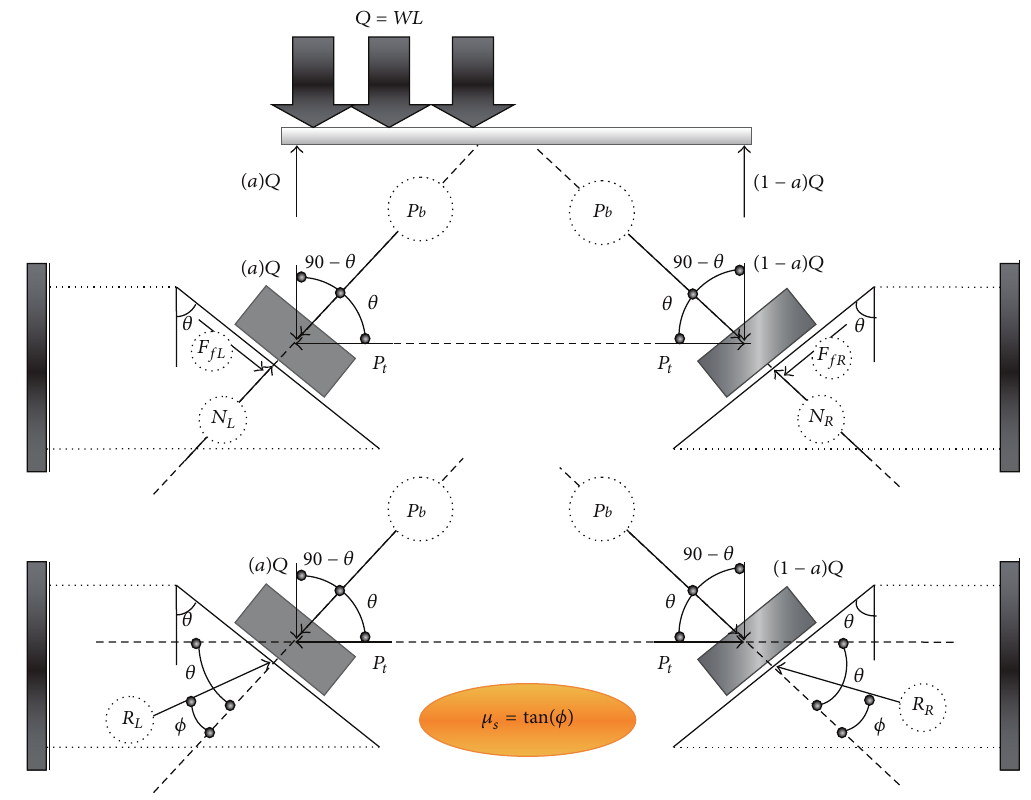
Figure 12: Free body diagram of beam with nonsymmetric gravity load after increase in temperature (friction bolted support).